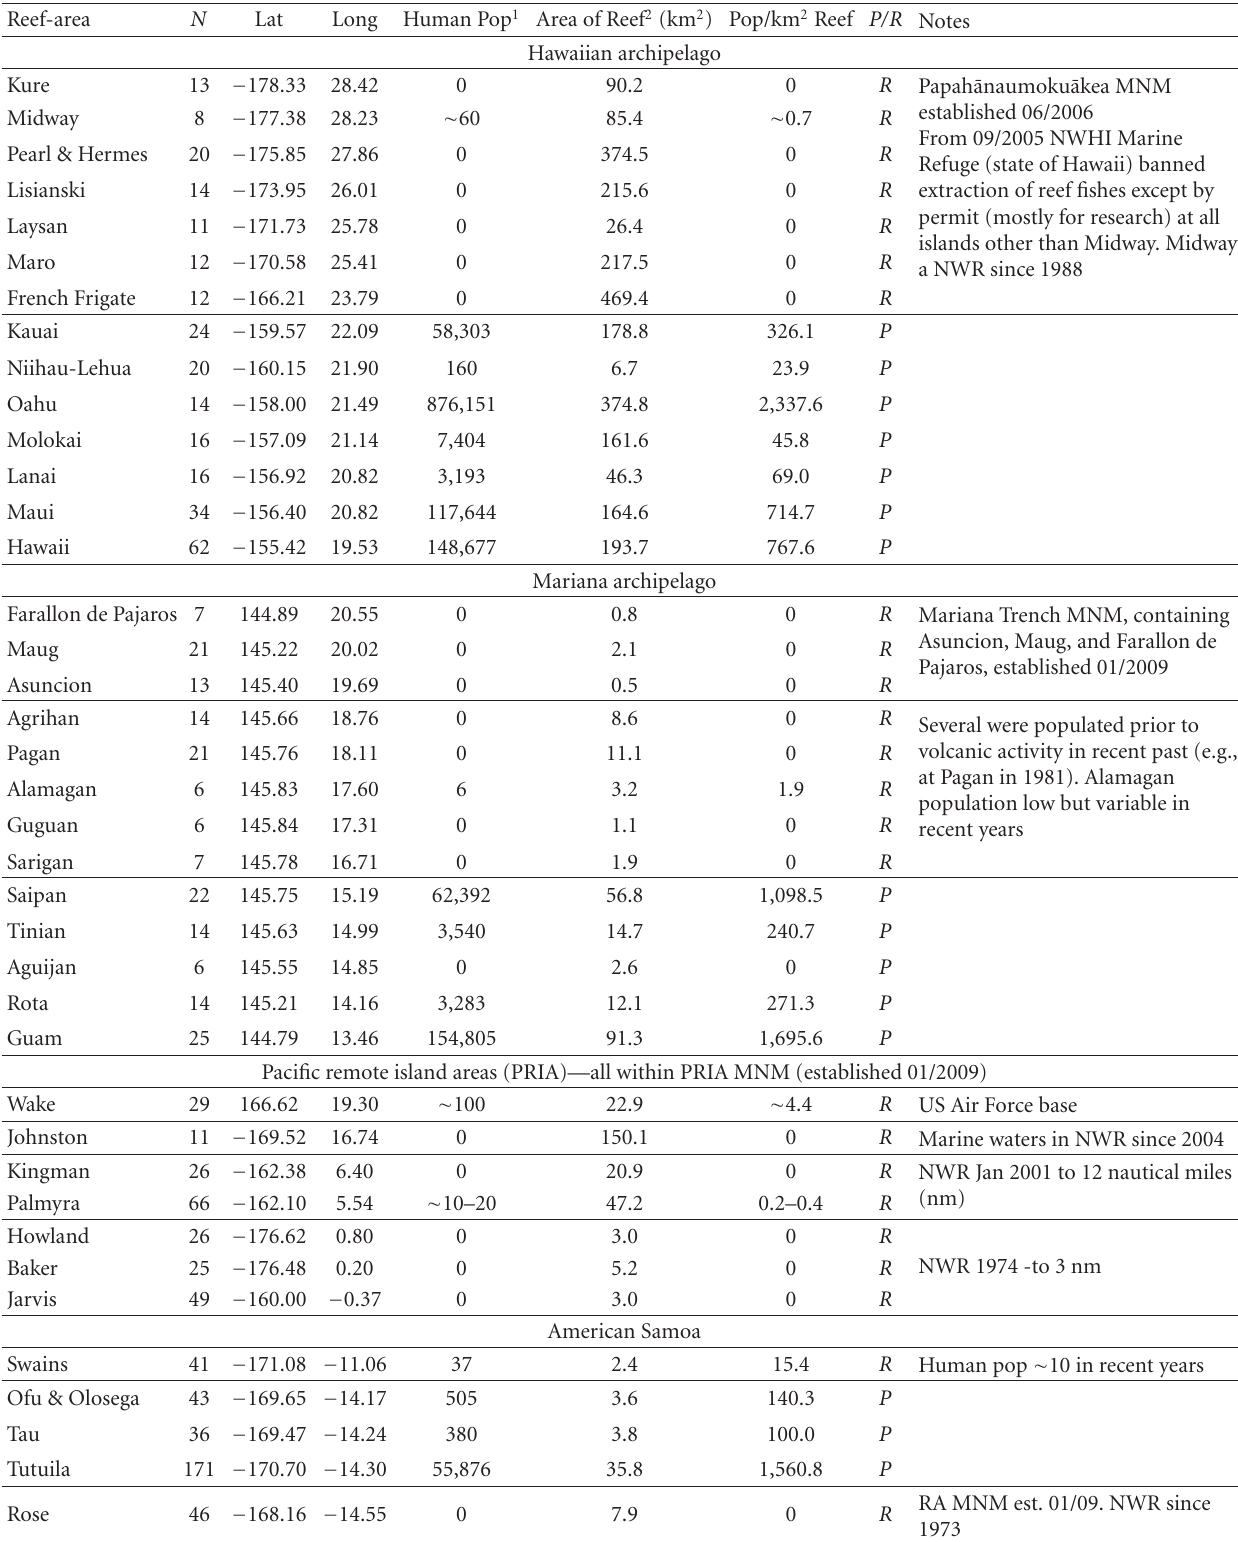
Table 1: Study Areas, Regions, and Status. MNM: Marine National Monument. NWR: US Fish and Wildlife Service National Wildlife Refuge. Shaded areas are those classified as remote. N : no. of sites